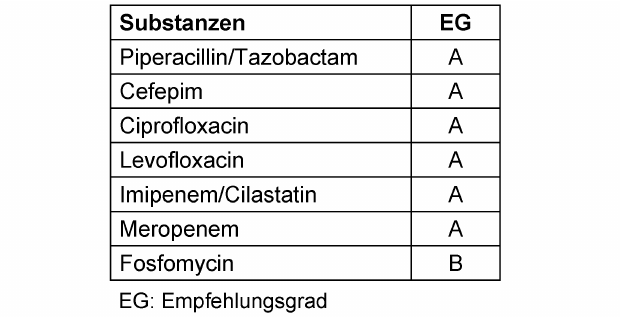
Tabelle 3: Empfehlungsgrade für den Einsatz der Antibiotika in der